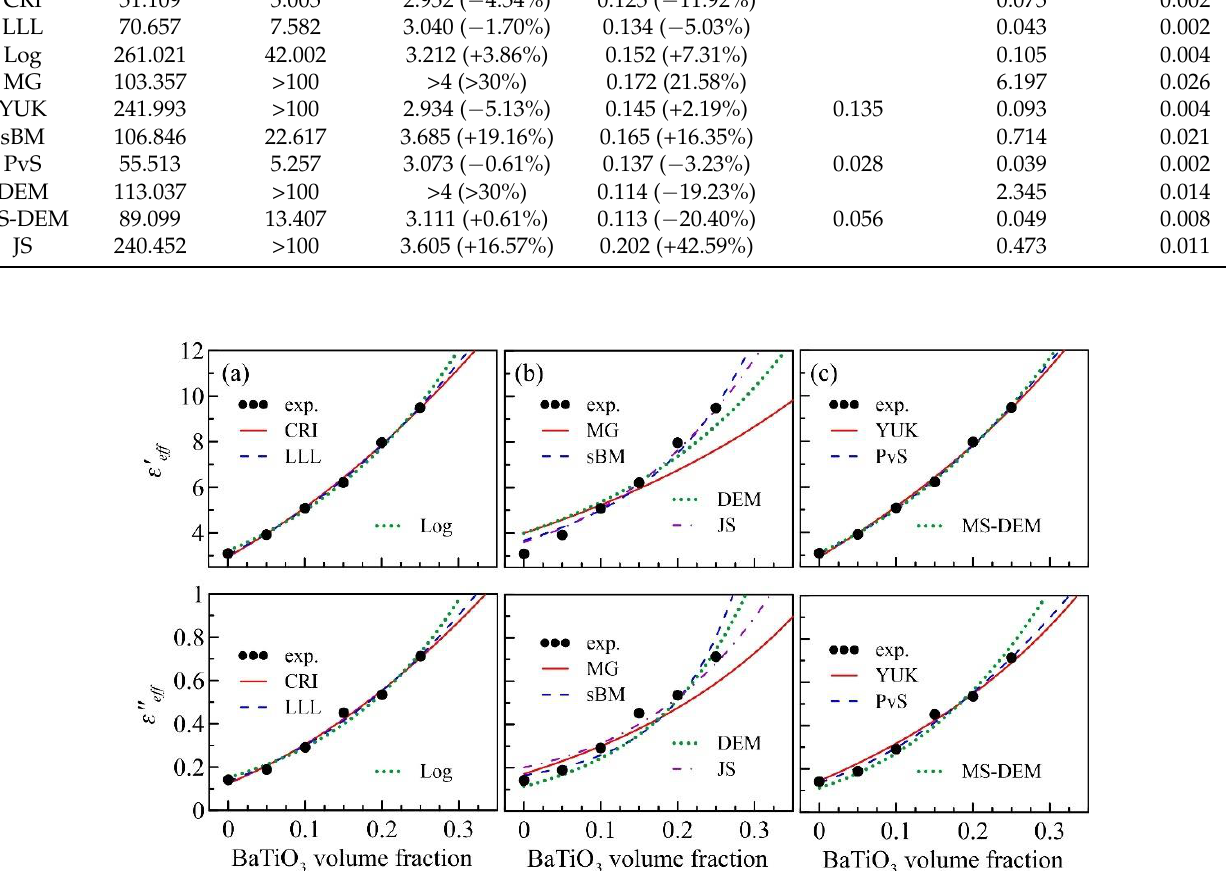
Table 2. Complex permittivity of BaTiO 3 powder ε p and epoxy ε h and depolarization factor ( N ) retrieved by the ten EMTs. Model